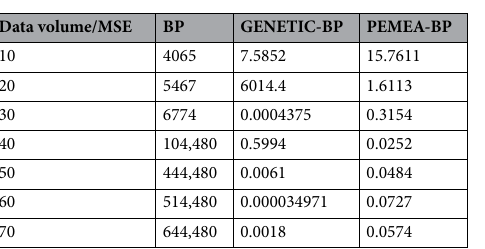
Figure 1. PEMEA-MP modified GM residual model flow chart.